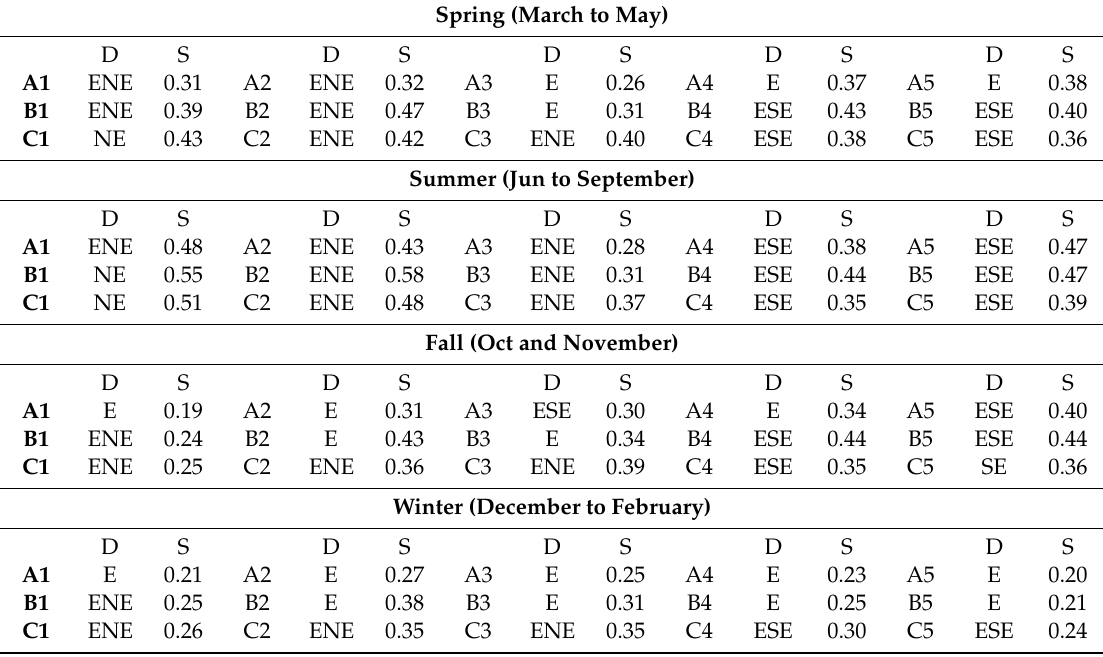
Table A3. Flow data during the ebb period from the CODAR data (Figure 9). S represent the flow speed (m / s) and D represents the flow direction (sixteen bearings).